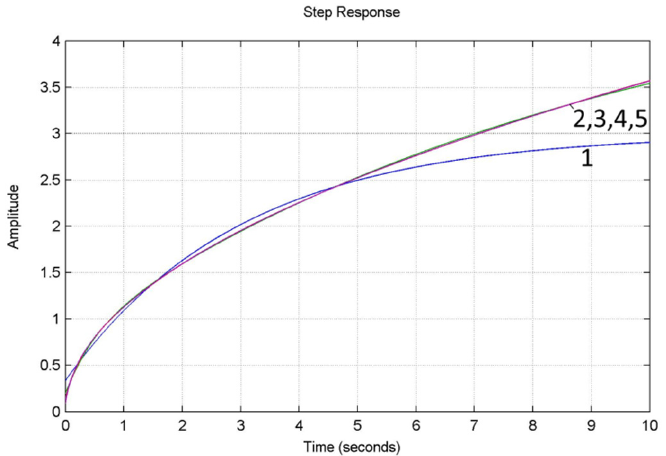
Figure 2. Frequency characteristics of parts (12)—1, (15)—2, (20)—3, (21)—4, (22)—5. Similarly, the graphs of the transition functions of theI λ parts ( α = λ = − 0.5), which are described by the TFs (13), (16), (23)–(25) (Figure 3), and the frequency characteristics of these TFs (Figure 4) were obtained.